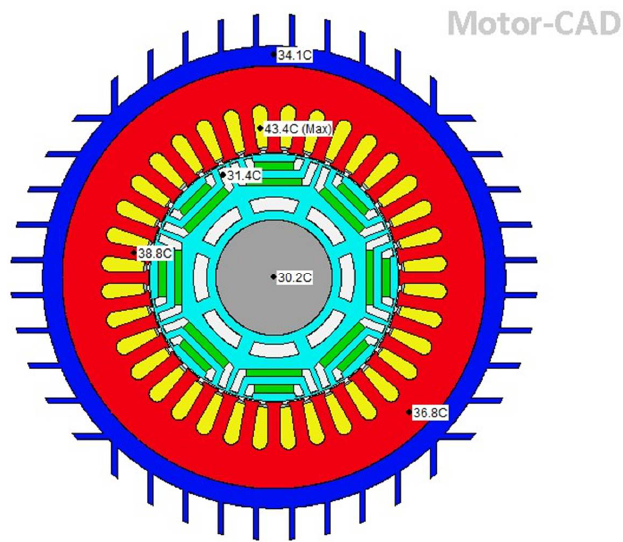
Figure 27. Thermal simulation model and temperature for the double layer IPMSM.